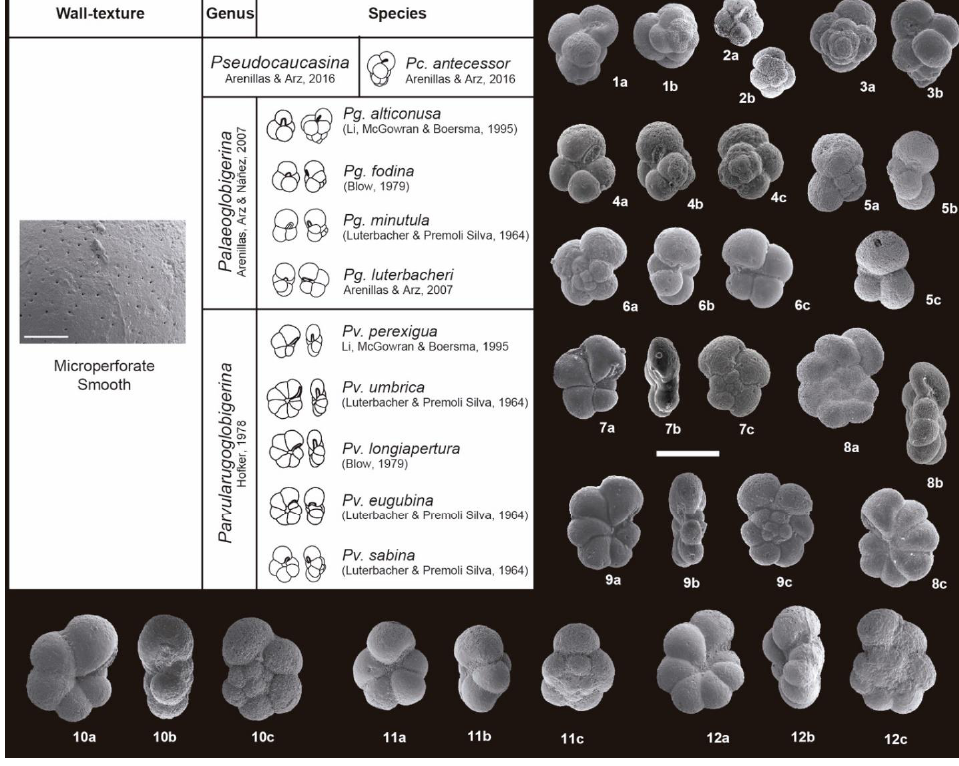
Figure A3. Species of Pseudocaucasina, Palaeoglobigerina, and Parvularugoglobigerina . 1. Pseudocaucasina antecessor ; 2. Ps. antecessor , juvenile specimen; 3. Palaeoglobigerina alticonusa ; 4. Palaeoglobigerina fodina ; 5. Pg. minutula ; 6. Pg. luterbacheri ; 7. Parvularugoglobigerina perexigua ; 8. Pv. umbrica ; 9. Pv. longiapertura (var. euskalherriensis ); 10. Pv. longiapertura (var. longiapertura ); 11. Pv. sabina ; 12. Pv. eugubina . See main diagnostic characters of these species and genera in Supplementary Text S1. Specimens are from El Kef (1–8,11,12), and Aïn Settara (9,10); juvenile specimen of Pseudocaucasina antecessor (2) reported by Brinkhuis and Zachariasse [93]. Scale bar = 100 µ